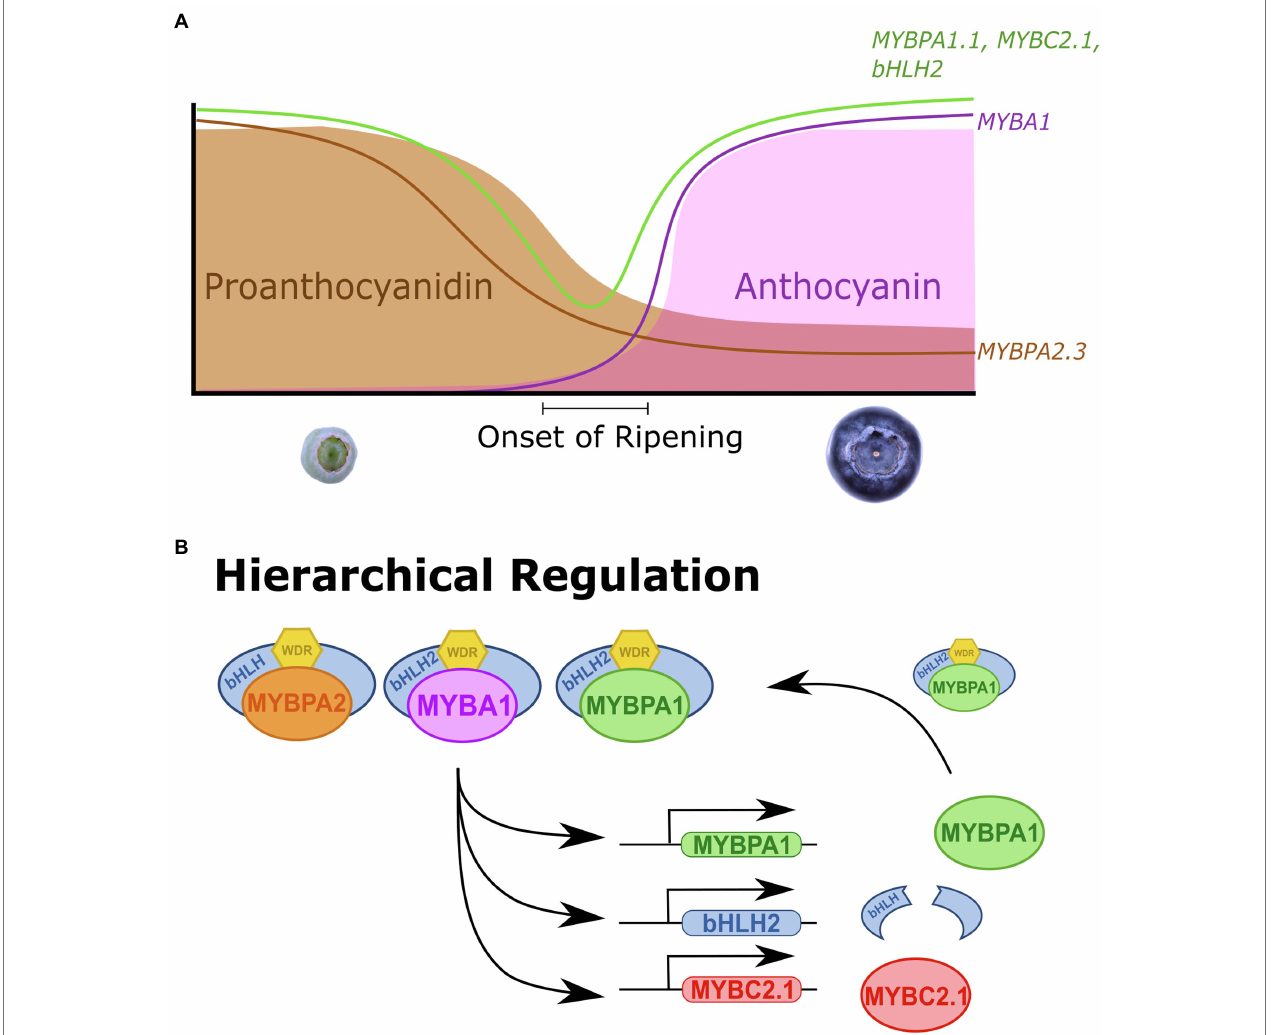
FIGURE 6 | Vaccinium MYB activators and repressors are coordinately regulated for precise control of proanthocyanidin and anthocyanin biosynthesis. (A) During early stages of Vaccinium fruit development (S1–S3) proanthocyanidin (PA) concentrations are high, before declining as development proceeds. This correlates